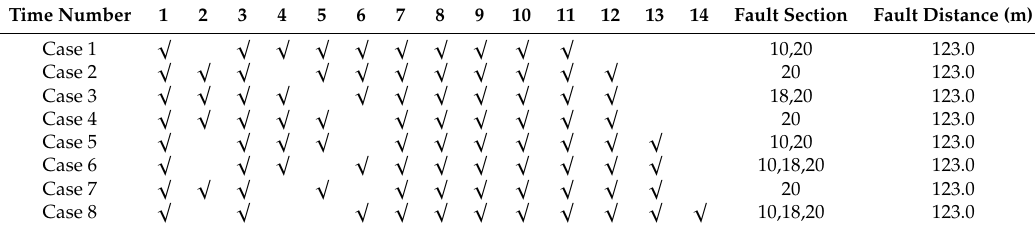
Table 9. Locating results with discontinuous measured